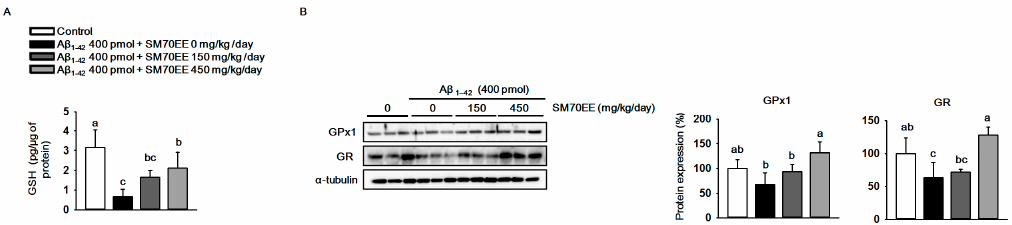
hippocampus ( n = 4 per group). ( B ) Mouse hippocampal lysates were subjected to western